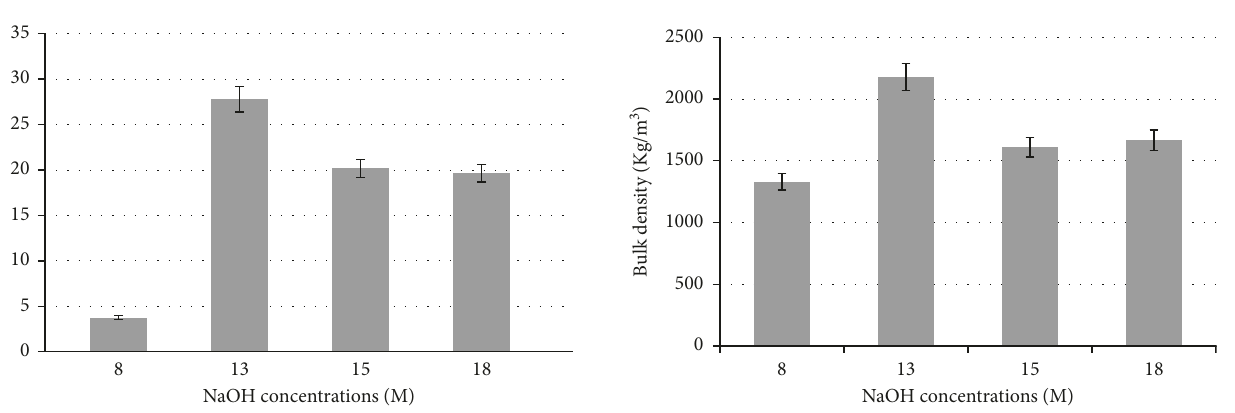
Figure 6: Bulk density of geopolymer cement prepared with various NaOH concentrations.